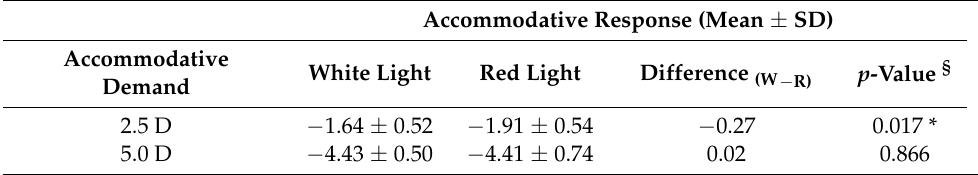
Table 6. Accommodative response (mean ± SD) in red and white light.